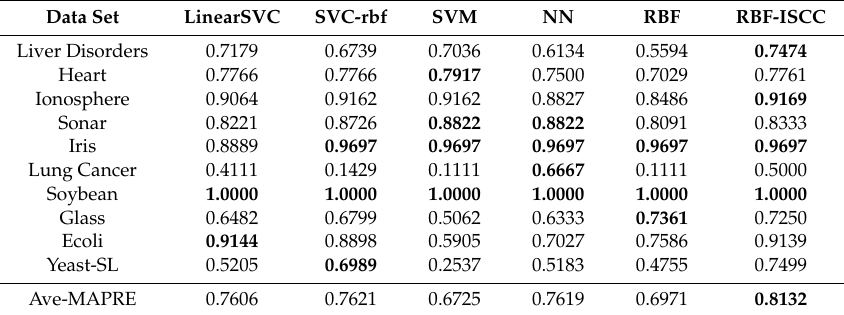
Table 5. Testing macro-averaged precision (MAPRE) obtained for single-label data sets.